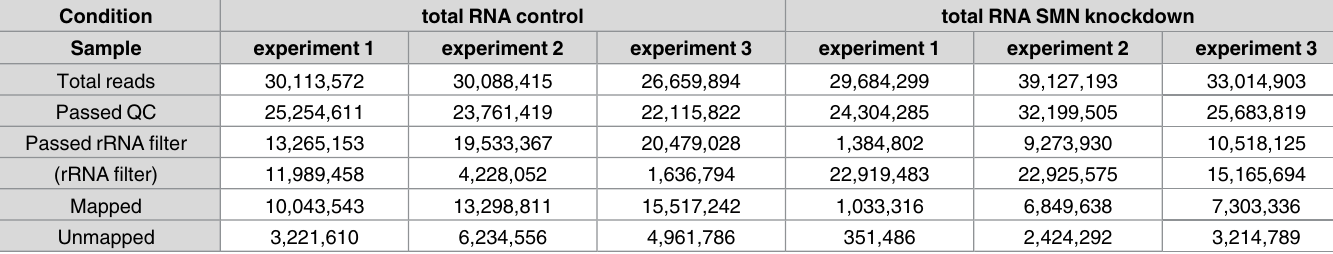
Table 5. RNA-seq workflow and quality control.